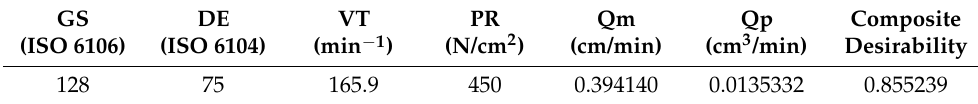
Table 5. Multi-objective optimization considering that Qp is